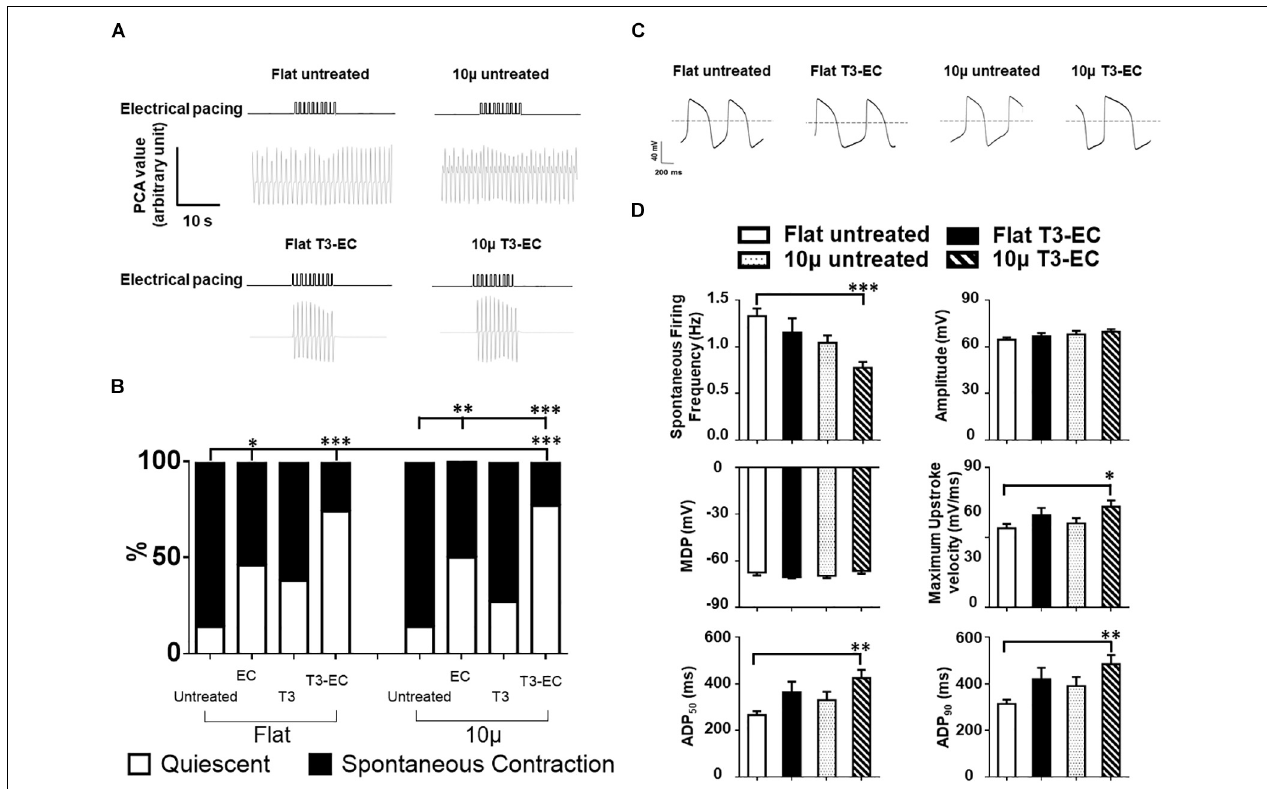
FIGURE 2 | Combined T3-EC treatment promotes the formation of quiescent but excitable hvCAS with a more matured electrophysiology. (A) Representative tracings of optical flow analysis showing the quiescent but excitable properties of hvCAS after T3-EC treatment. (B) Combined T3-EC treatment significantly reduces spontaneous contraction in hvCAS (14 batches of independent differentiations; sample size: flat untreated, flat T3-EC, 10 µ untreated, and 10 µ T3-EC = 31–36, flat EC, flat T3, 10 µ EC, and 10 µ T3 = 11–13). (C) Representative spontaneous AP tracing of single hESC-VCMs redissociated from hvCAS by whole-cell patch clamping. (D) Spontaneous AP parameters (four batches of independent differentiations; n = 15–24 for each group). (A) Chi-square test between two groups. (D) One-way ANOVA test, followed by Dunnett multiple comparison test to flat untreated control. ∗ p < 0.05, ∗∗ p < 0.01, and ∗∗∗ p < 0.001.